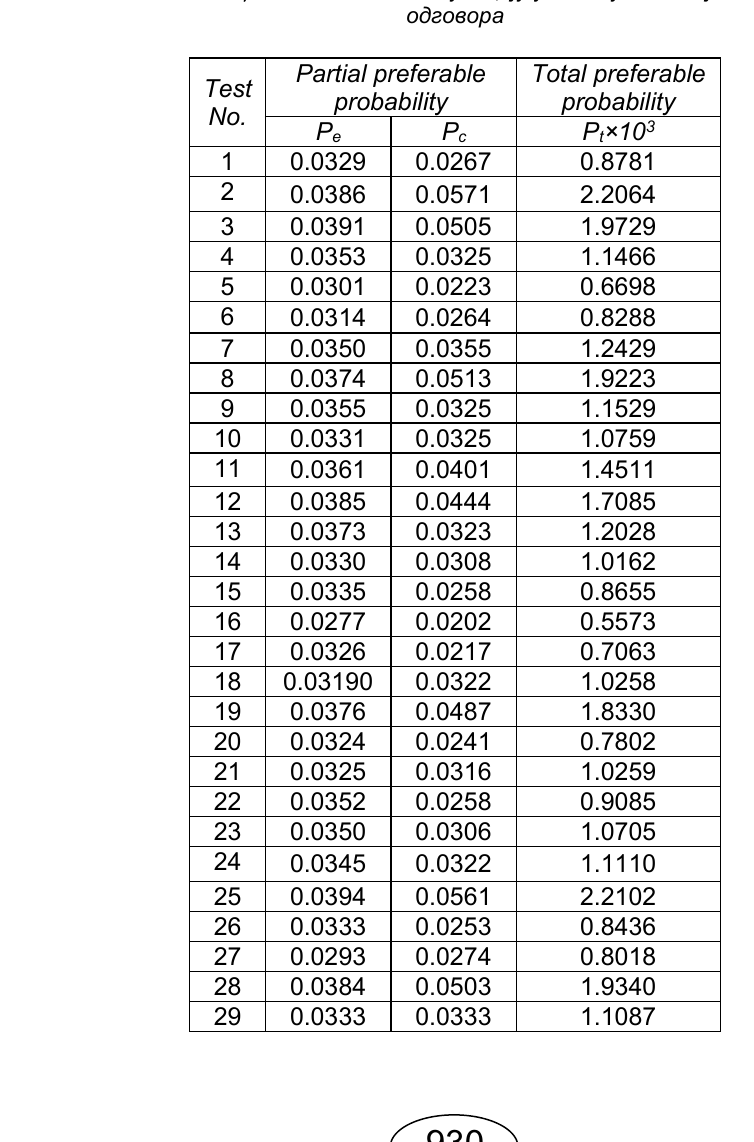
Table 2 – Evaluation results of the preferable probability of utility in the preparation of the encapsulation composite of WSC /  -PGA-TA in the spirit of a response surface